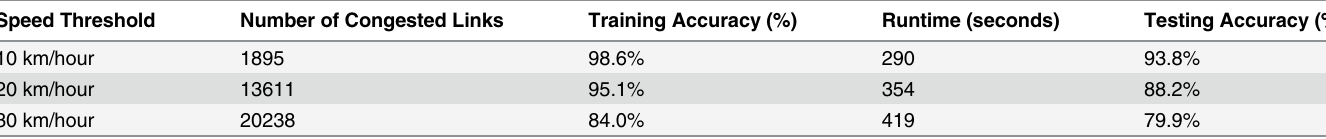
Table 4. Sensitivity analysis of congestion evolution prediction performance with various speed